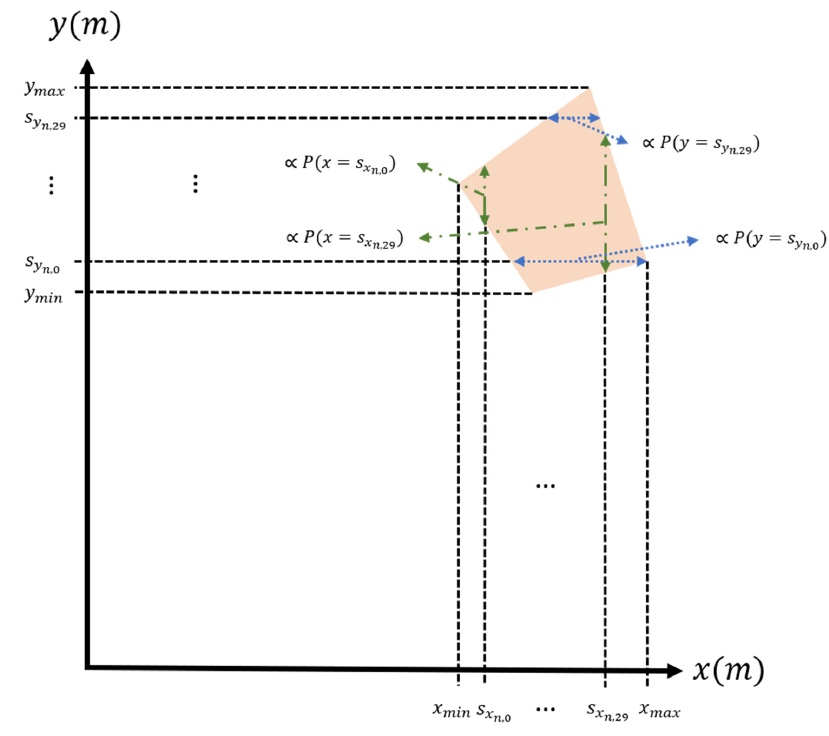
(cid:0) (cid:1) y = s y (cid:4667) . Figure 8. The example of calculating the probability P n , i (cid:3289),(cid:3284)